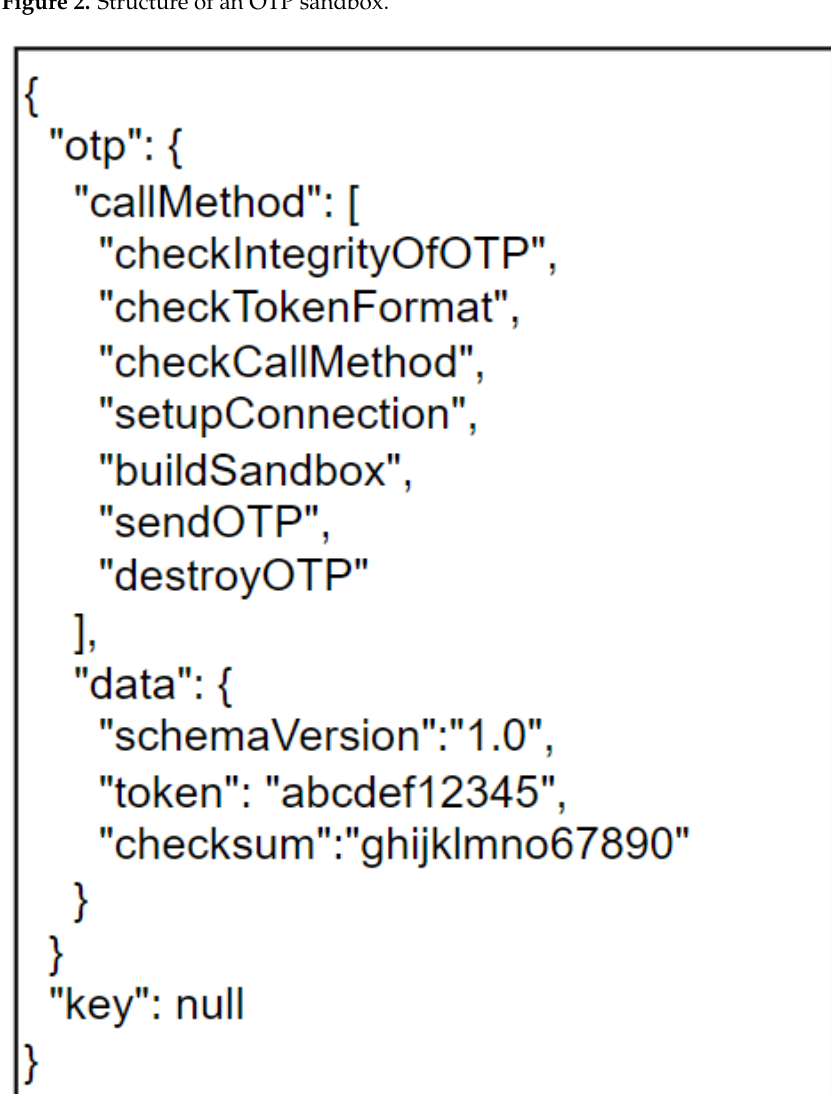
Figure 2. Structure of an OTP sandbox.